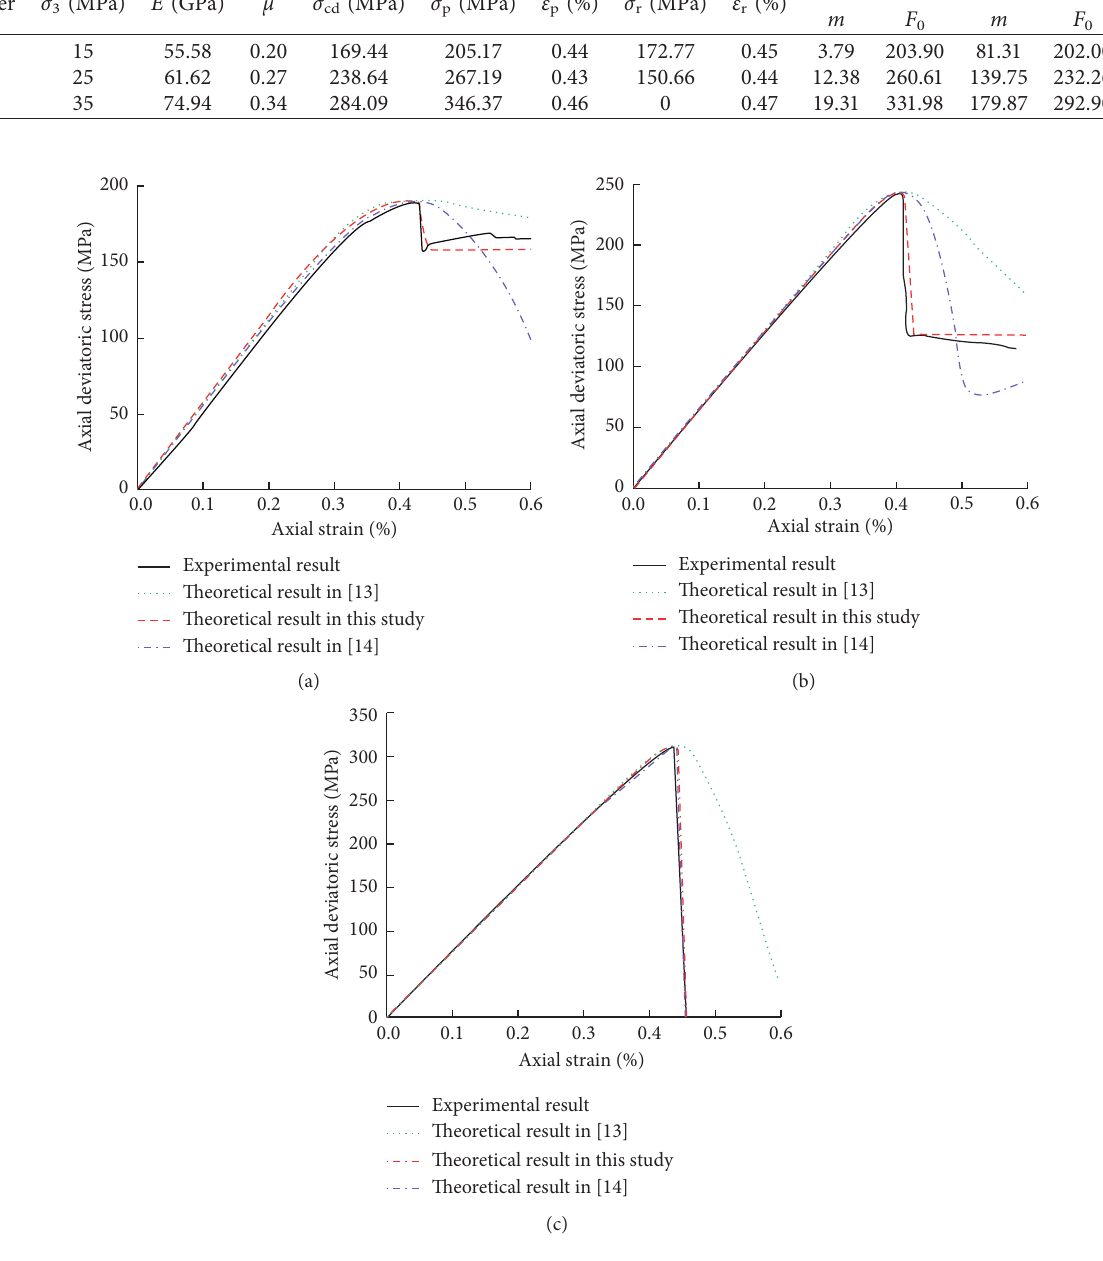
Figure 5: The complete stress-strain curve: (a) 15MPa; (b) 25MPa; (c) 35